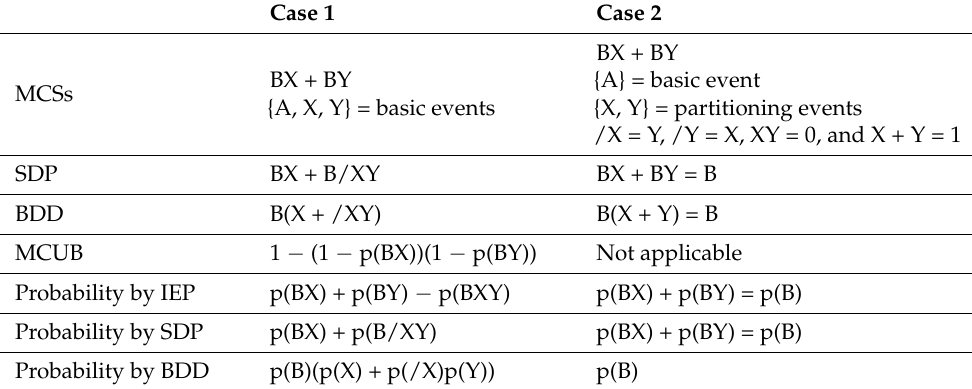
Table 1. Probability calculations with simple minimal cut sets